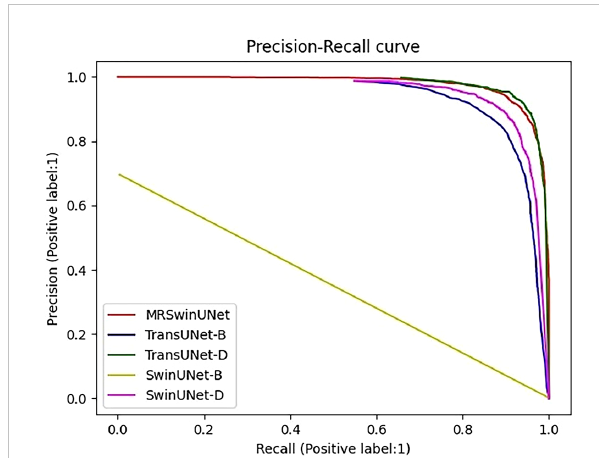
FIGURE 3 Precision-Recall curve. The label is 1, which means the infested root system is the positive sample. MRSwinUNet is our improved segmentation model. The TransUNet-B and TransUNet-D represent the TransUNet models using BCE loss and SGDM, Dice loss, and Adam, respectively. SwinUNet-B and SwinUNet-D represent the SwinUNet models using BCE loss and SGDM, Dice loss, and Adam,